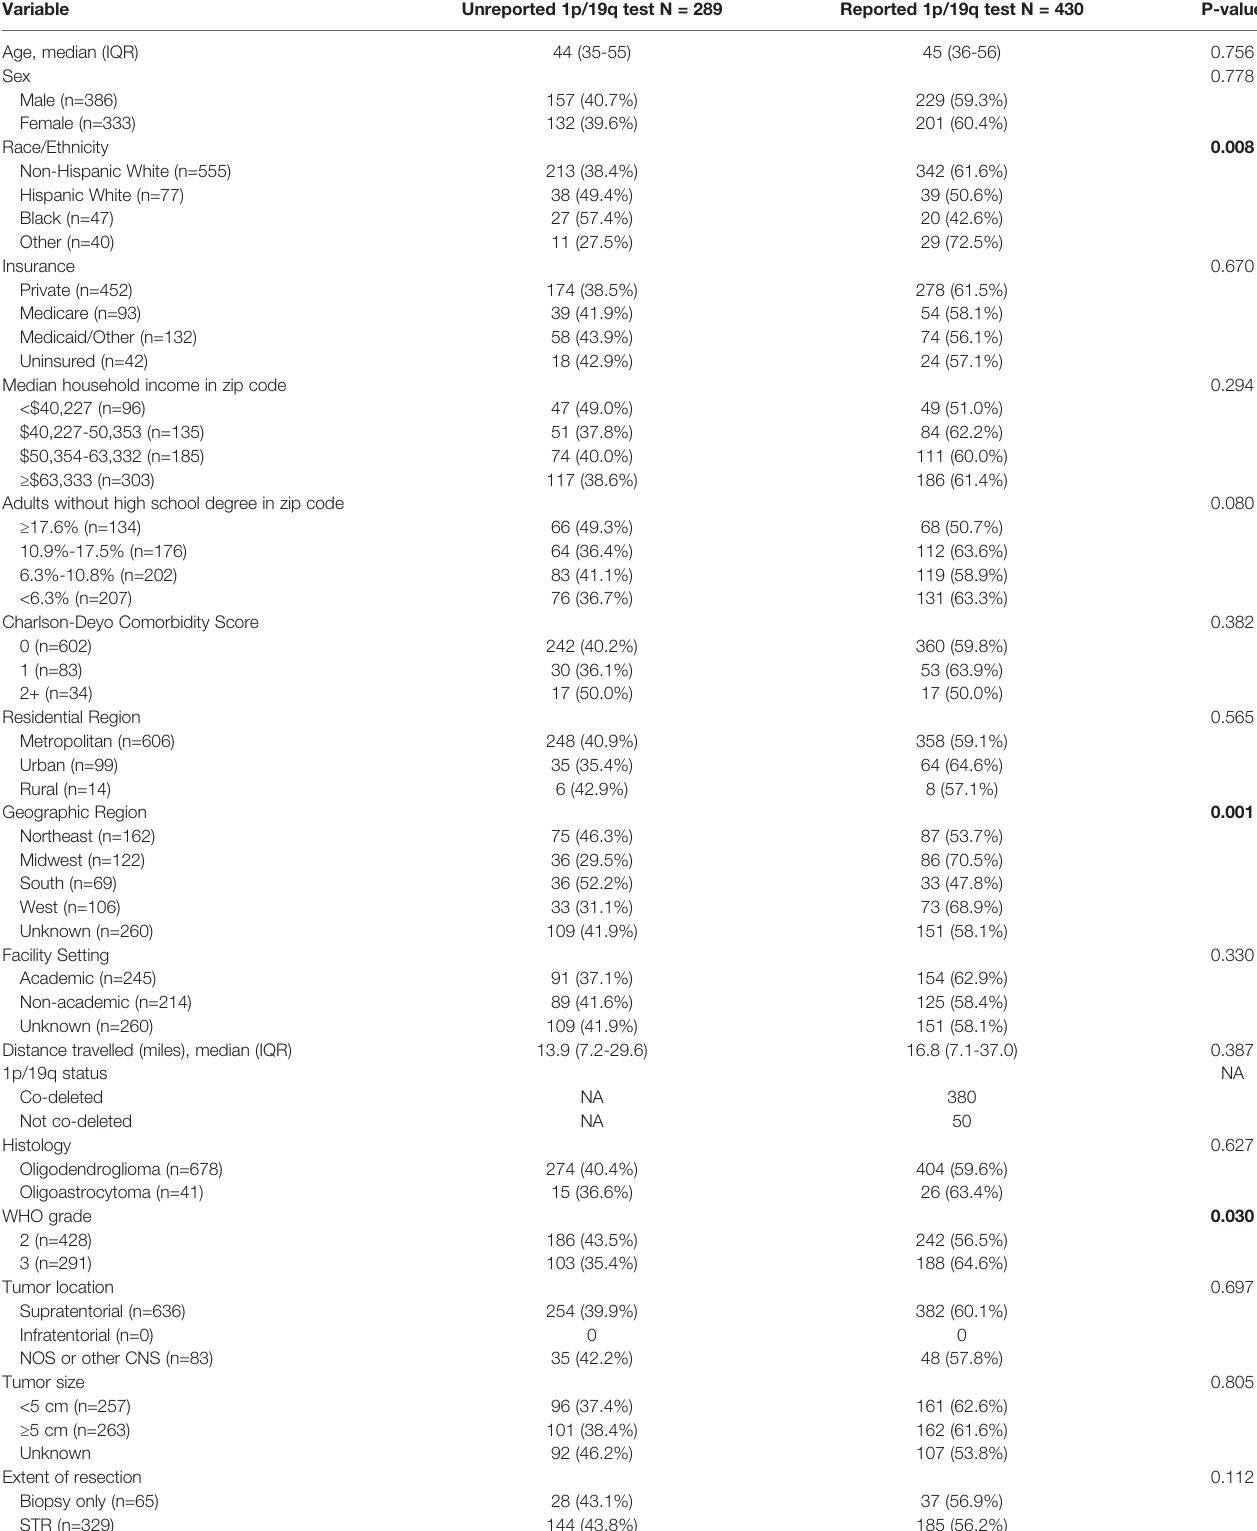
TABLE 3 | Characteristics of patients with and without a reported 1p/19q codeletion test diagnosed in 2017. Frequencies and proportions are